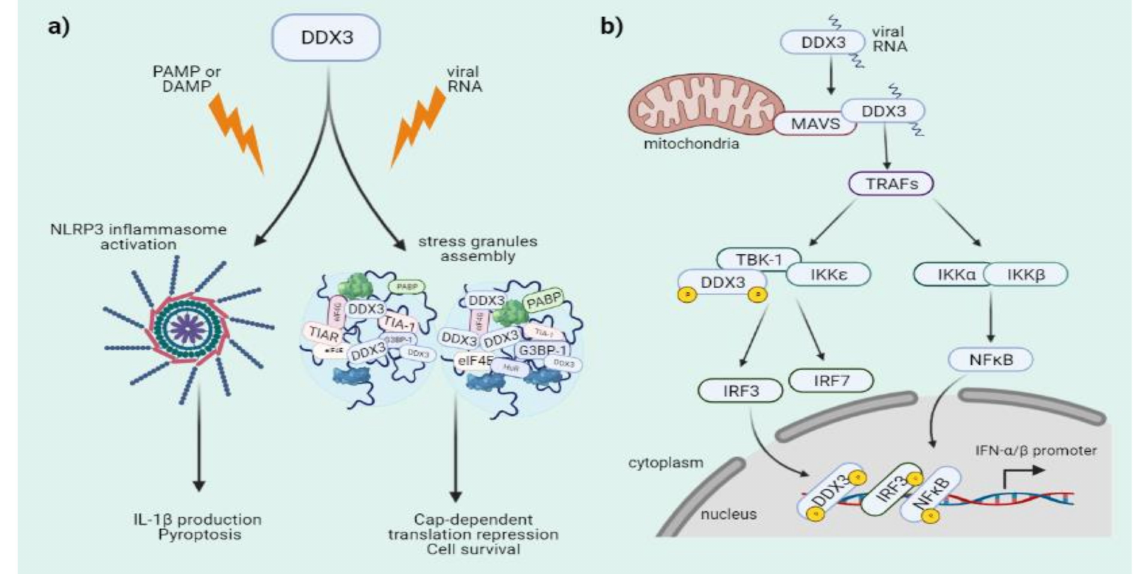
Figure 3. DDX3 participates in immune signaling pathways. ( a ) DDX3 participates in cell fate decisions through NLRP3- inflammasome activation or stress granules assembly. ( b ) DDX3 is a key component during innate immune response participating in sensing of viral RNA and MAVS activation but also as a phosphorylation target and a co-transcriptional factor in the type I IFN production signaling pathway.